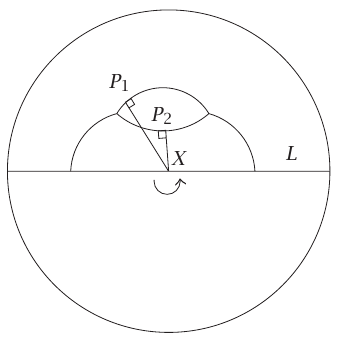
Figure 7.4 . Generating curve for a possible nonstandard minimizer, and a set of points p i from which orthogonal lines meet the axis of revolution at the same (finite)